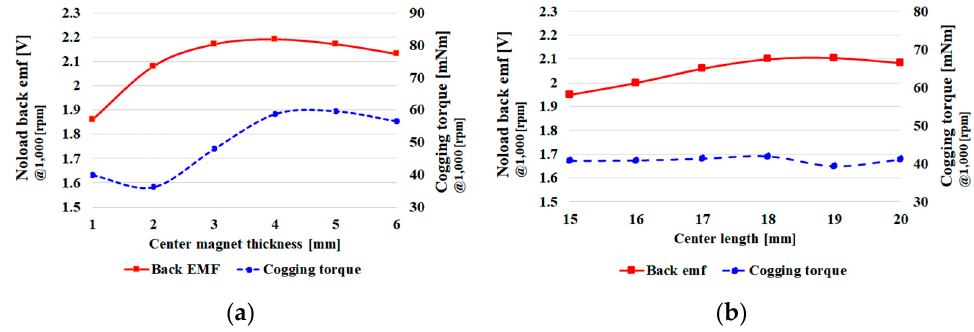
Figure 10. Performance analysis according to center magnet thickness and length: ( a ) noload back EMF, ( b ) cogging torque.